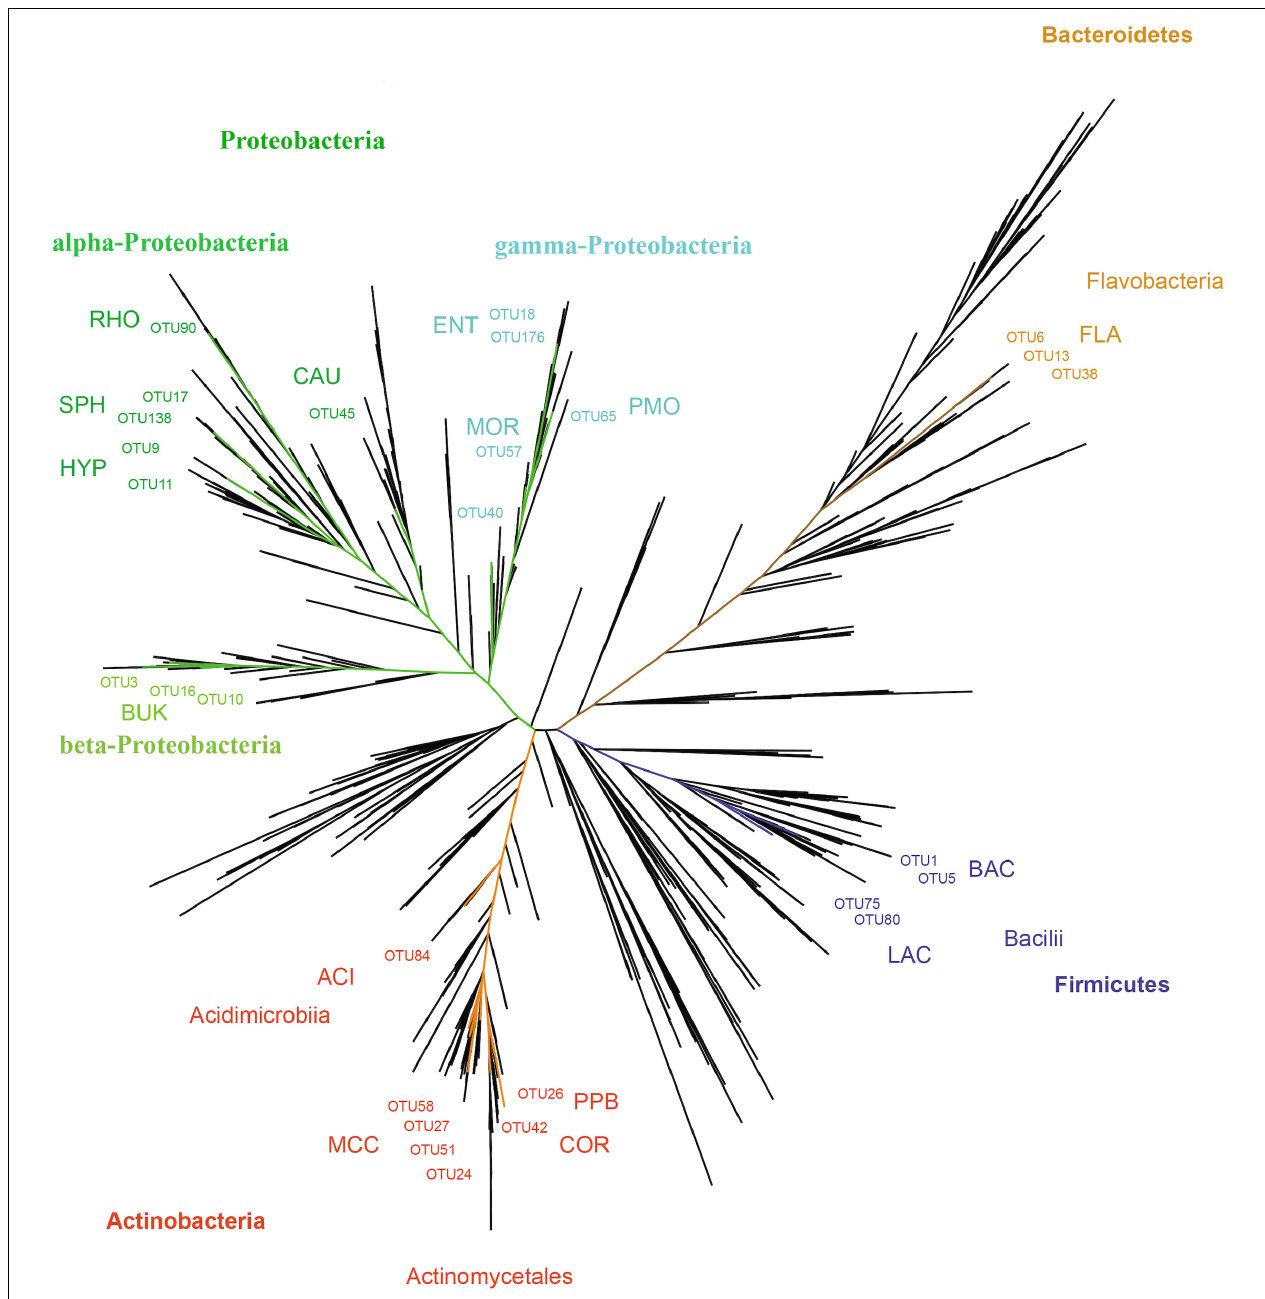
FIGURE 3 | Unrooted phylogram showing the relationships of OTUs. The 28 OTUs shared among all samples are marked and classified. The main lineages (phylum) detached are marked using a color code: Actinobacteria (red), Bacteroidetes (brown), Firmicutes (blue), Protobacteria (brown). Besides phyla, the placenta of classes and orders are marked with the later abbreviated: ACI = Acidimicrobiales, BAC = Bacillales, BUK = Burkholderiales, CAU = Caulobacterales, COR = Corynebacteriales, ENT = Enterobacteriales, FLA = Flavobacteriales, HYP = Hyphomicrobiales, LAC = Lactobacillales, MCC = Micrococcales, MOR = Moraxellales, PMO = Pseudomonadales, PRO = Propionibacteriales. RHO = Rhodobacterales, SPH = Sphingomonadales.